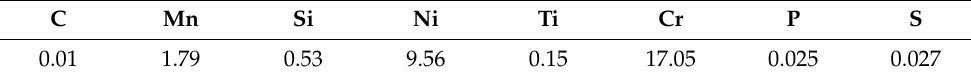
Table 1. Chemical composition (%) of steel 316L, according to